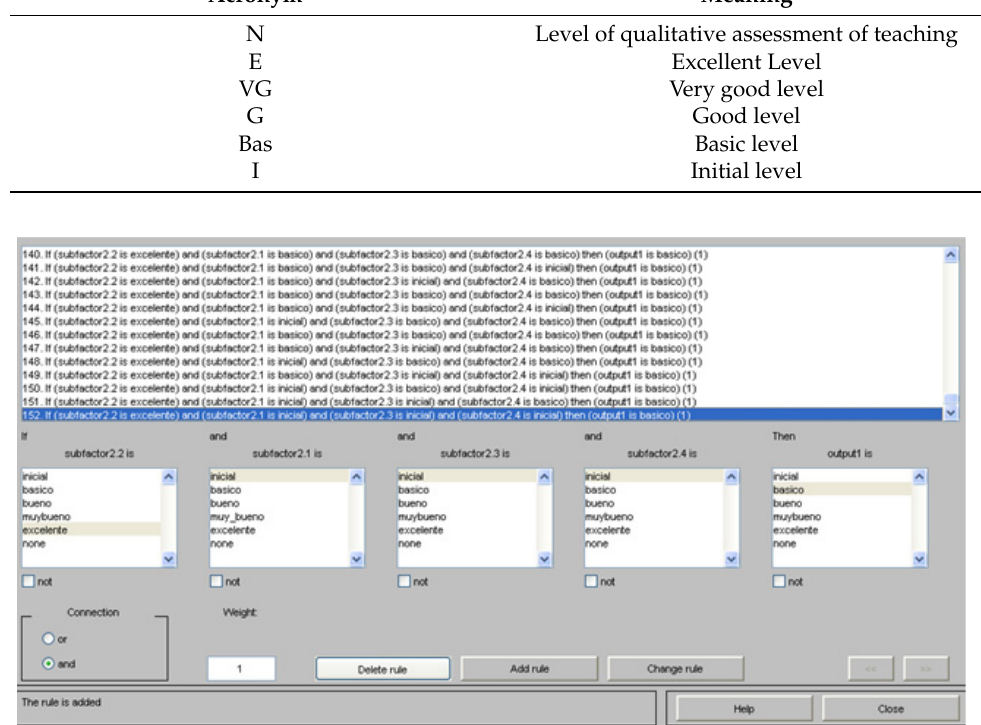
Figure 2. Fuzzy rules system extract. Source: own elaboration through the MatLab ® Fuzzy Tool